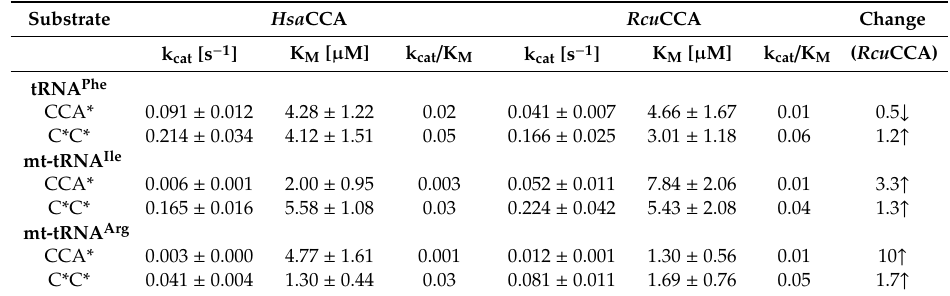
Table 1. Kinetic parameters of Hsa CCA and Rcu CCA for CC- and A-addition. As indicated by the relative activity of Rcu CCA compared to Hsa CCA (change), CC-addition on standard and